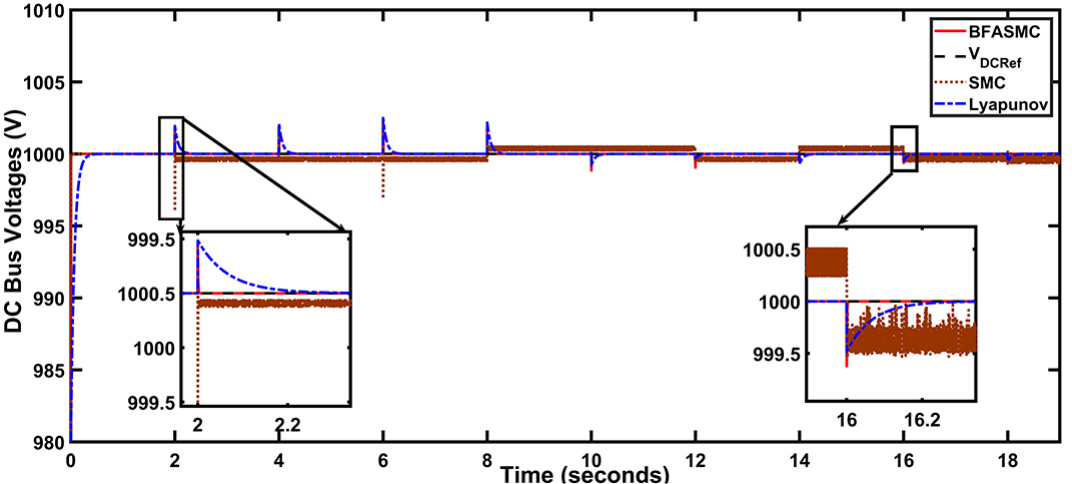
Figure 13. DC bus comparison during grid connection.